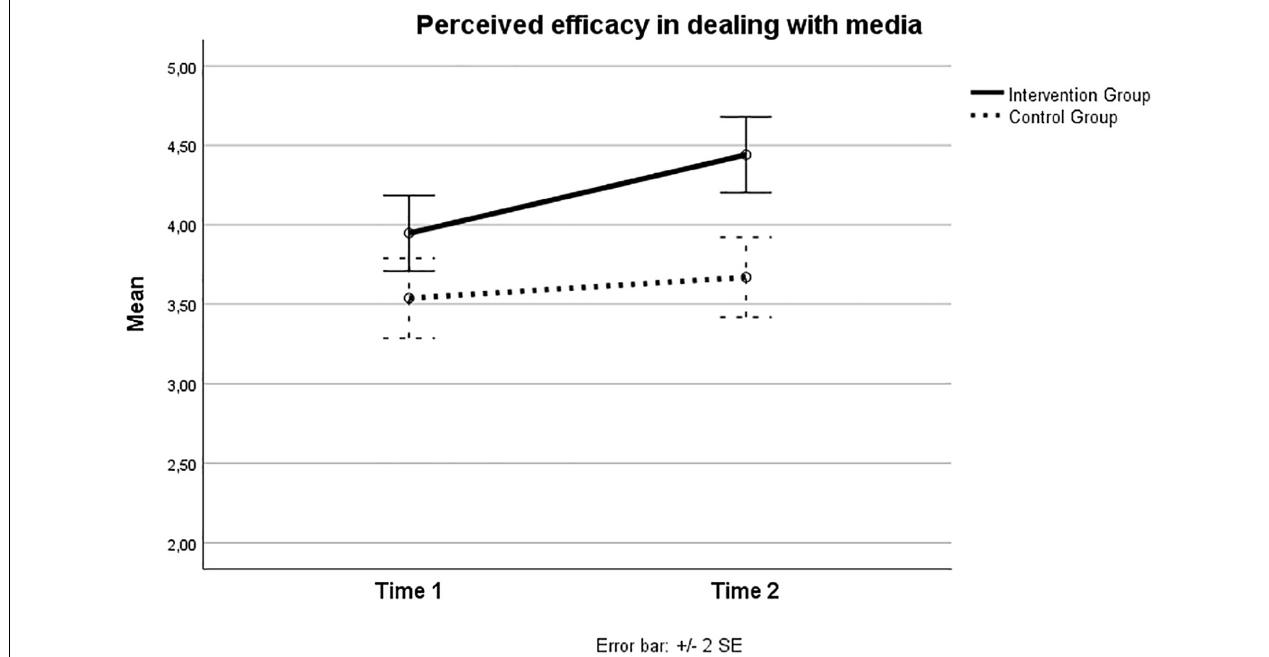
FIGURE 2 | Perceived self-efficacy in dealing with media across time in intervention and control